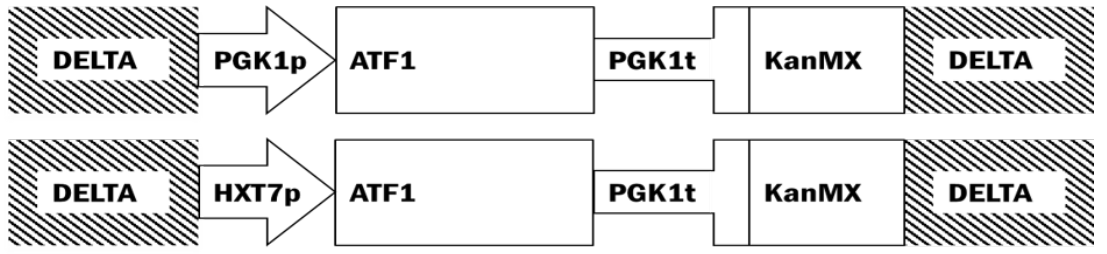
Figure 1. Relevant features of the pBKD1-derived plasmids used in the study. Plasmids were linearized with XhoI endonuclease (located in delta (Ty) genetic elements).